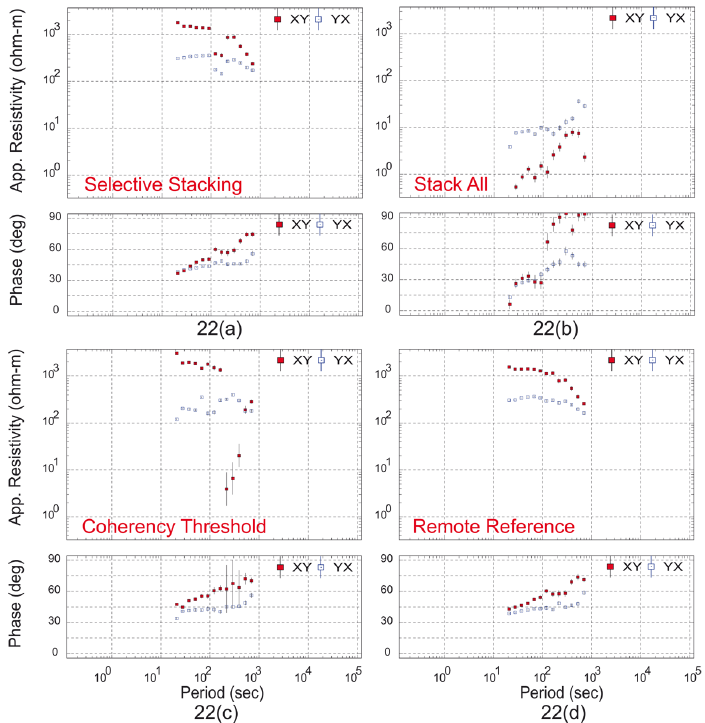
Figure 22. Outcome of 4S sampling data of site K11 from Koyna profile with different processing methods keeping the other parameters constant. (a) Apparent resistivity (upper panel) and phase (lower panel) curves obtained from the data using Selective Stacking. (b) Apparent resistivity (top panel) and phase (bottom panel) curves of the same data obtained from Stack All. (c) Apparent resistivity (top panel) and phase (bottom panel) curves from Coherency Threshold for the same data set. (d) Apparent resistivity (upper panel) and phase (bottom panel) curves obtained from the data applying Remote Reference provide a better result than the others. If remote site is not available then Selective Stacking is more acceptable which is followed by Coherency Threshold (with carefully chosen threshold values) and Stack All. The red colored boxes represent XY components and the blue colored boxes represent YX components of apparent resistivity and